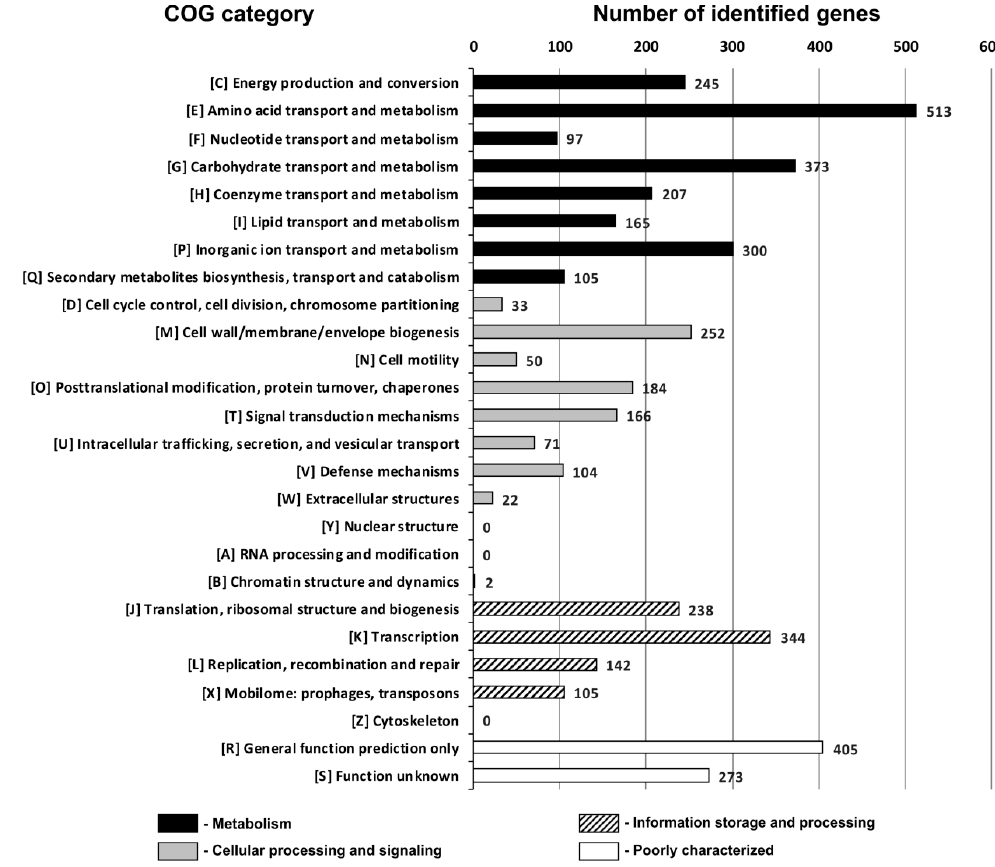
Figure 2. Number of genes classified into particular COG functional categories.